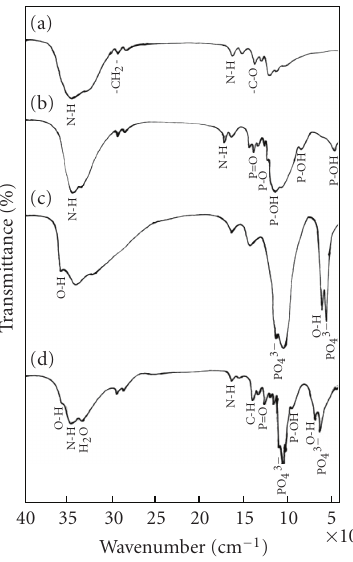
Figure 2: FTIR spectra of (a) chitosan, (b) chitosan phosphate, (c) HAp powder, and (d) HAp/CSP nanocomposite.